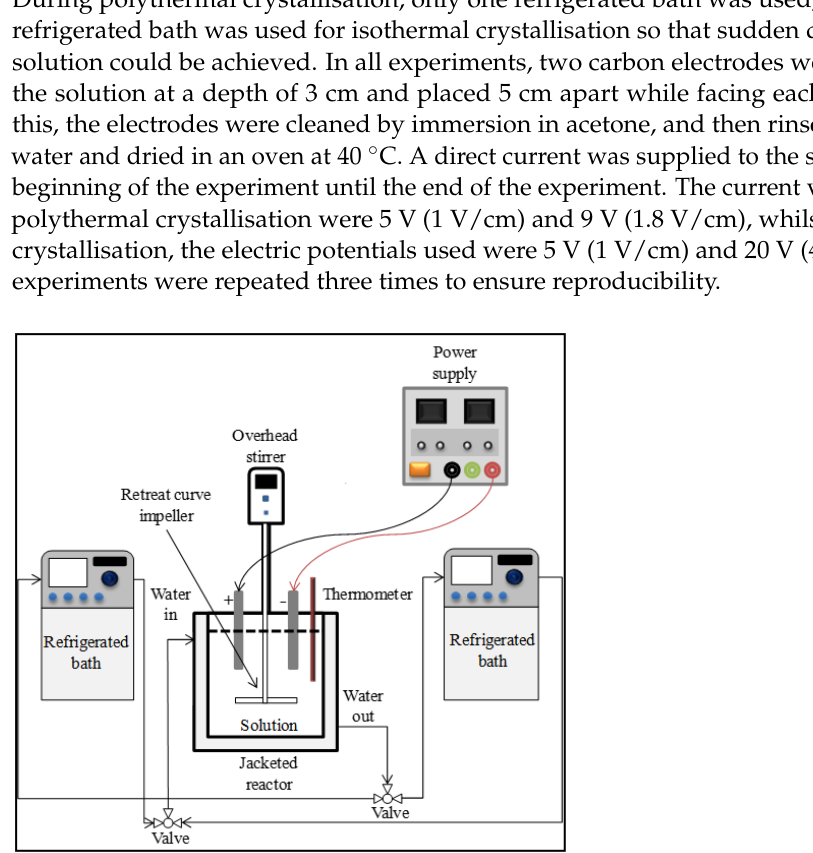
Figure 1. ( a ) Asymmetric unit of form A, forming dimer interactions, and ( b ) the asymmetric unit arrangement of the form B polymorph, consisting of four molecules in an asymmetric unit.